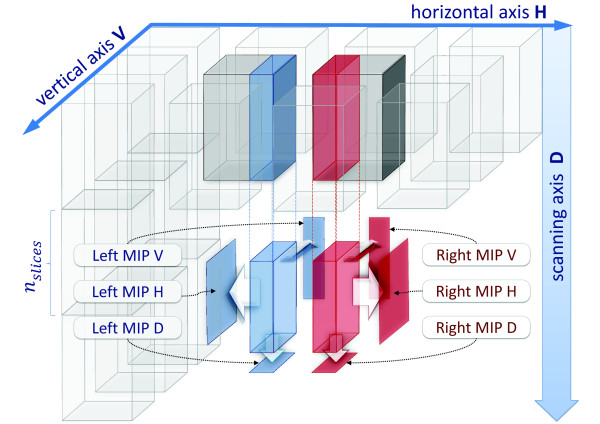
Multi-MIP-NCC method. Each tile is split along the D direction into substacks of nslicesslices. For each couple of adjacent substacks, three MIPs along the three directions are extracted from the overlapping regions. Then a 2D-NCC map is computed for each pair of homologous MIPs, so obtaining two displacements for each direction. Two reliability measures extracted from the NCC map are used to select for each direction the best of the two available displacements.